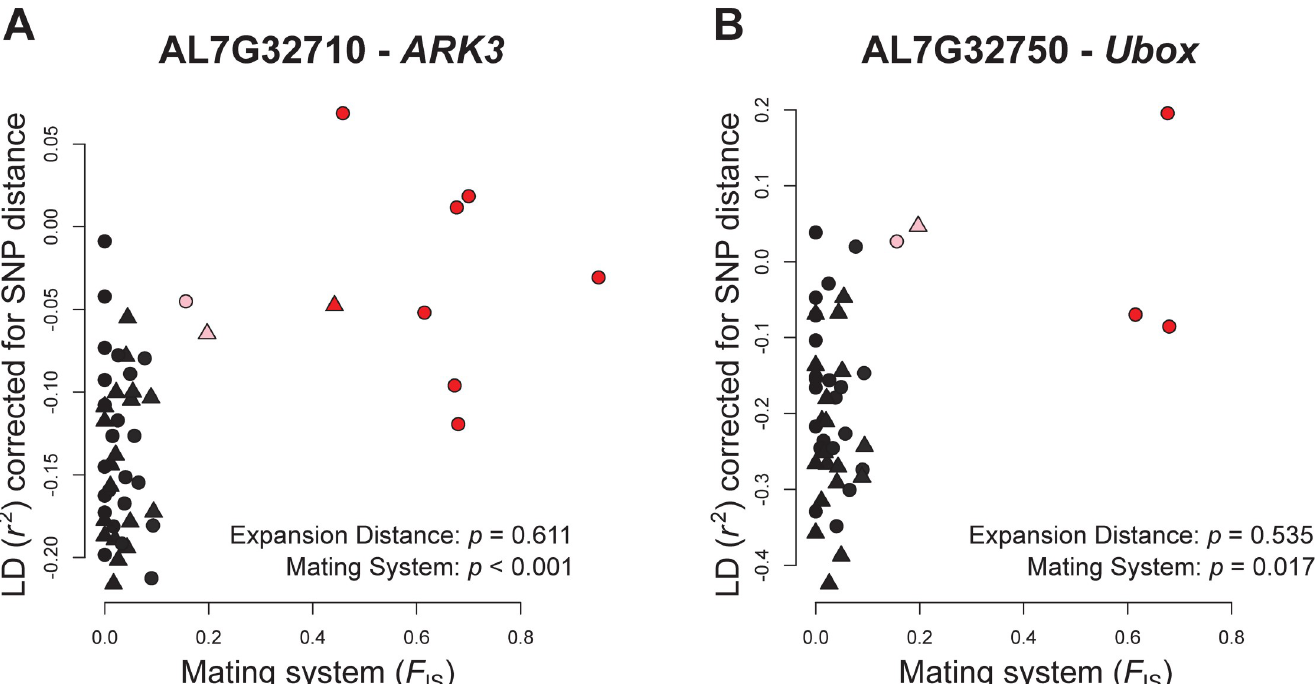
Fig 4. Relationship between average linkage disequilibrium (LD, distance-corrected r 2 between pairs of SNPs) in the two genes flanking the self-incompatibility locus and mating system, expressed by the population inbreeding coefficient ( F IS ): AL7G32710-ARK3 (A) and AL7G32750-Ubox (B). Each symbol represents the average estimate of a population. The symbol type reflects the genetic clusters (circle for west, triangle for east) and the symbol colour the mating system: outcrossing (black), mixed-mating (pink), and selfing (red). Significance is reported for the effects of expansion distance and mating system, from separate linear models on the data for each gene. For the gene AL7G32750- Ubox in B, the relationship with mating system was not significant following a False Discovery Correction.